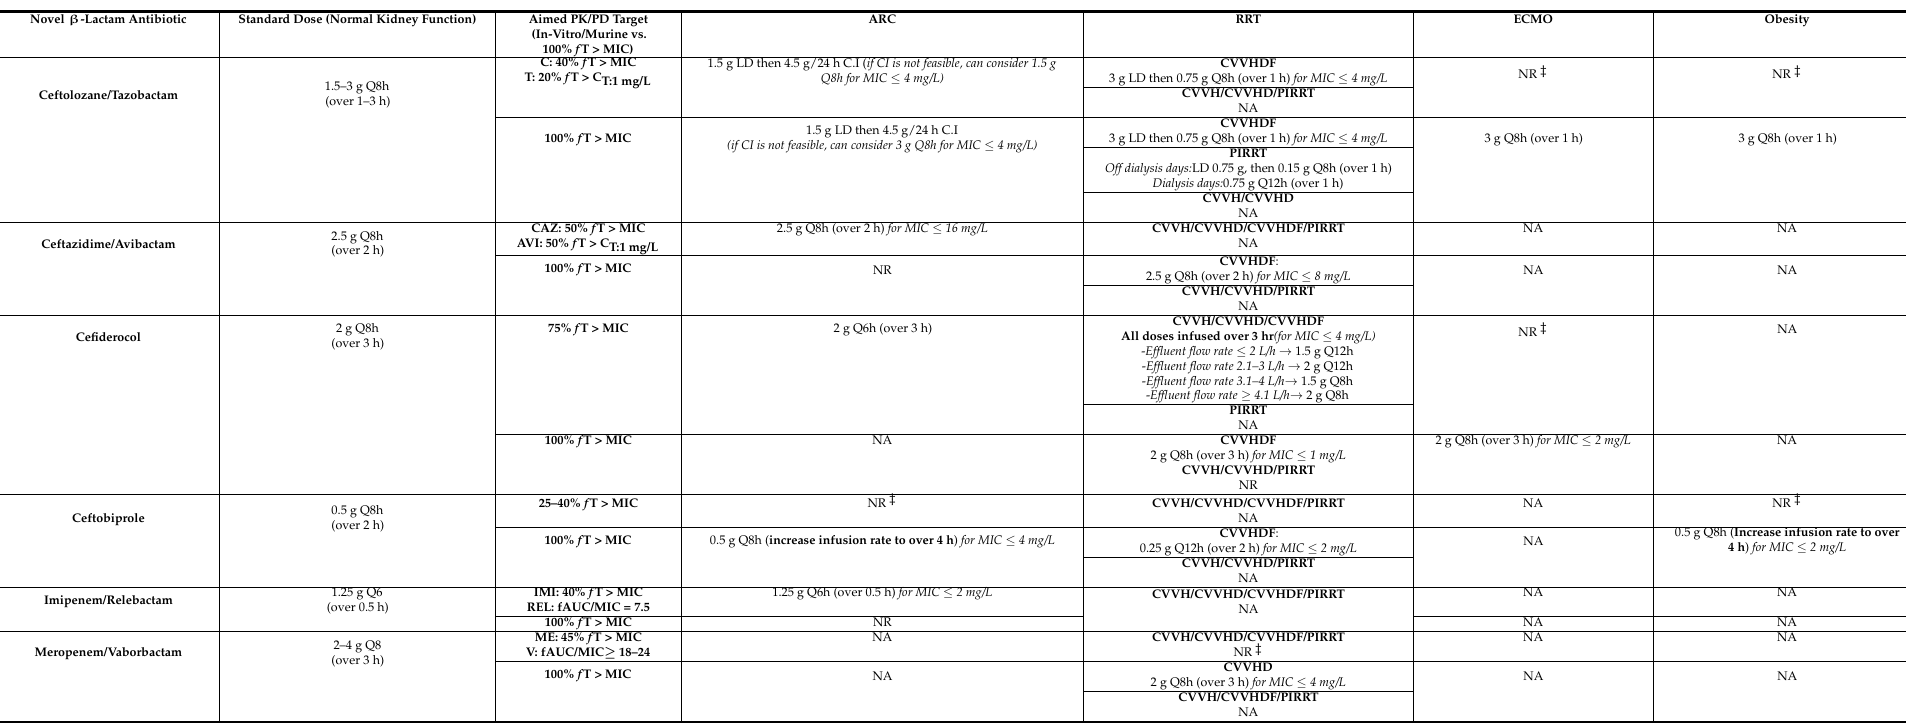
Table 3. Suggested initial dosing of novel β -lactam antibiotics based on aimed PK/PD targets among critically ill patients with special scenarios. Novel β